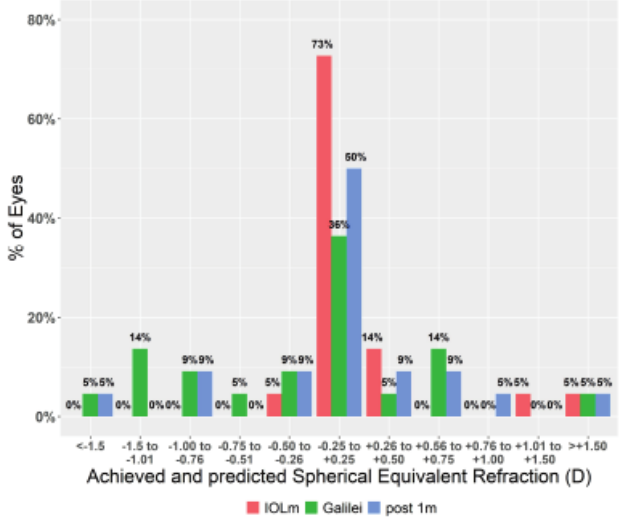
Figure 3. Comparison of achieved and predicted spherical equivalent.